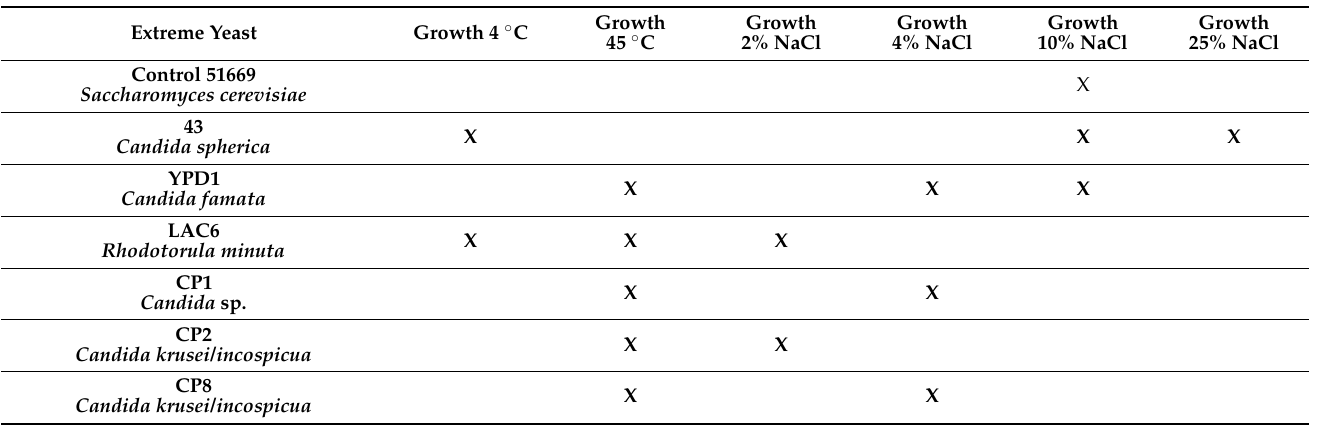
Table 3. Extremophile yeasts found in marine sediments (concentration of salt and temperature). (X) Highlights the growth of yeasts at the temperatures and salt concentrations studied.